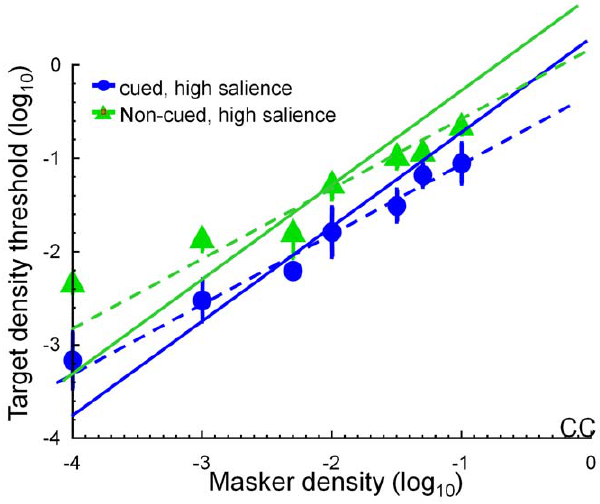
Figure 4. The slopes of the TvD functions. The solid lines have a slope of 1, the dashed lines, a slope of 0.75. The lines with unity slope tend to overestimate thresholds at high masker density and underes- timate them at low masker density.